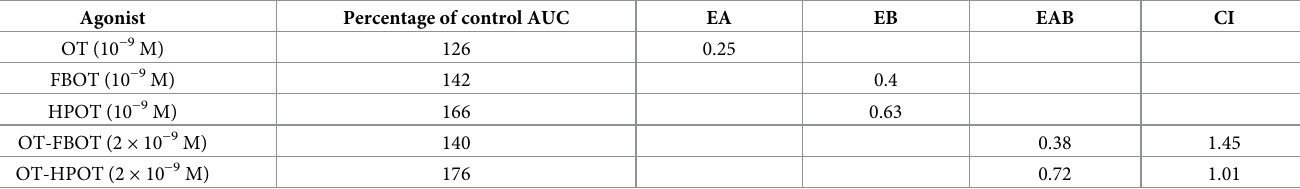
Table 2. Additivity using the Bliss independence model.